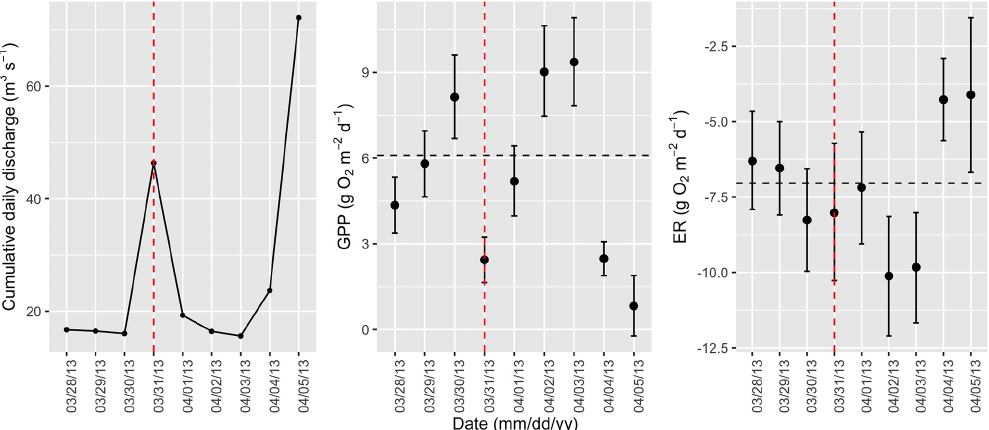
Figure A5. Cumulative daily discharge and metabolism (gross primary production and ecosystem respiration; GPP and ER) time series for the Stroubles Creek flow event on 31 March 2013 (noted with a dashed vertical red line in all three panels). The dashed horizontal black lines are mean values of GPP and ER prior to the high flow event. Error bars for posterior estimates of GPP and ER are 2.5% and 97.5% Bayesian credible